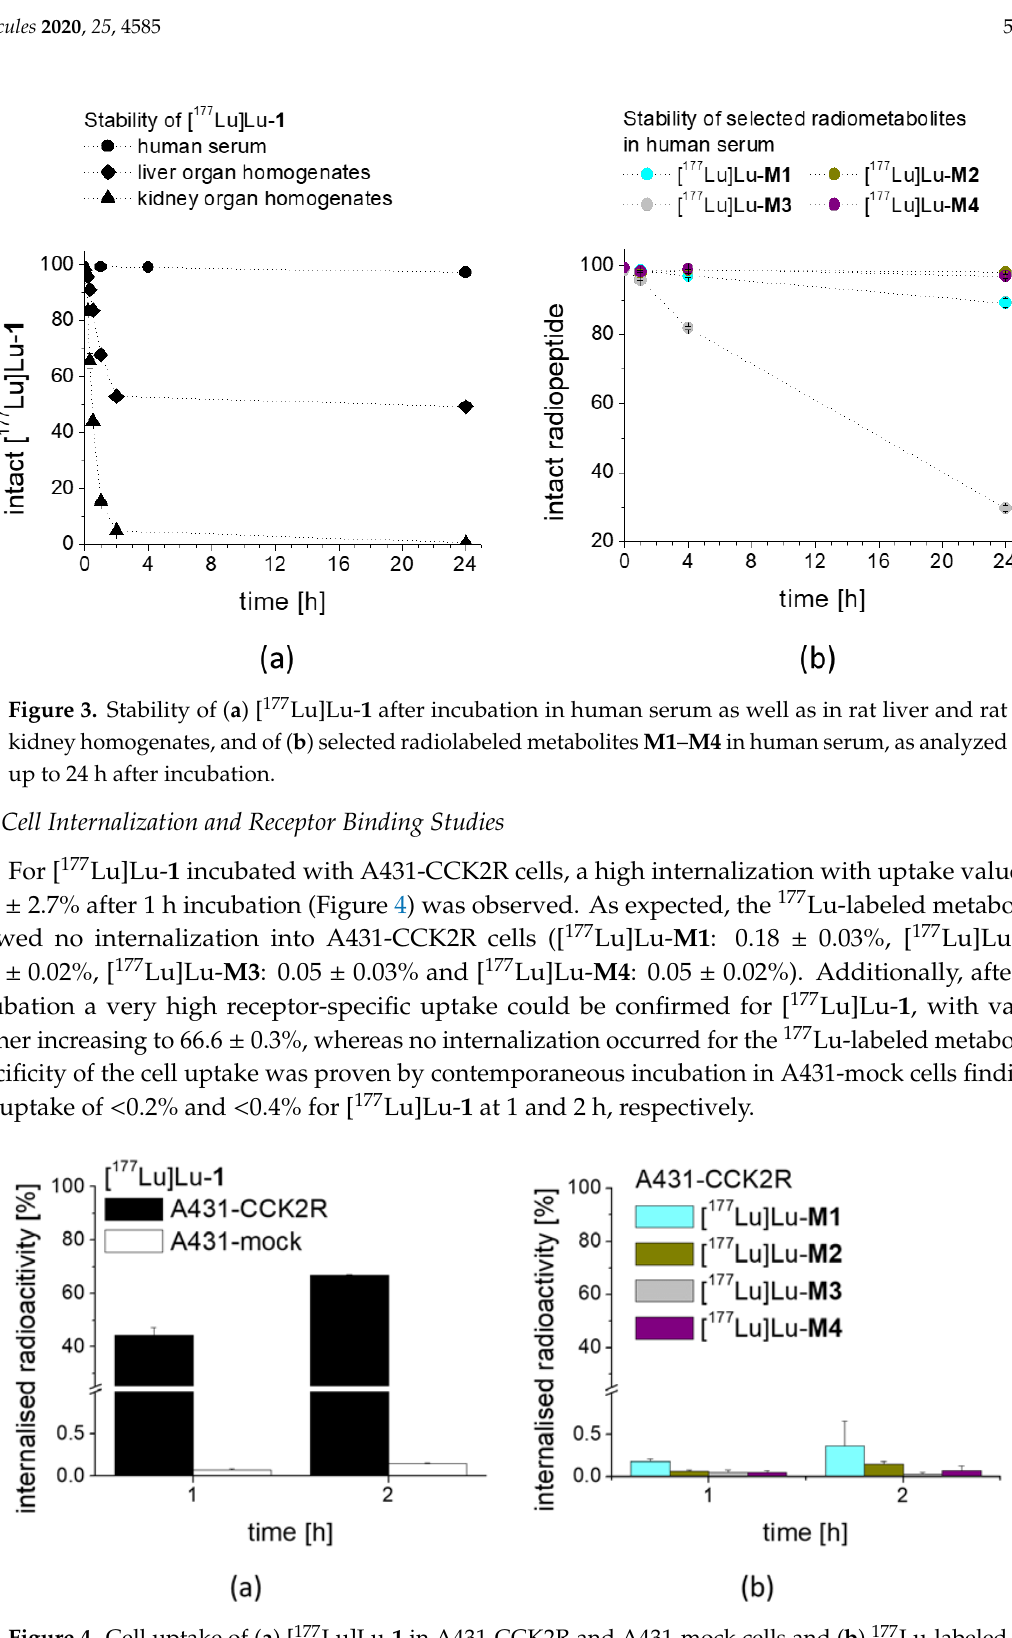
Figure 5. Competitive binding curves against [ 125 I][3-iodo-Tyr 12 ,Leu 15 ]gastrin-I for ( a ) non-labeled 1 in comparison with pentagastrin, as well as ( b ) non-labeled M1 – M4. 2.4. Stability In Vivo and Biodistribution Studies The metabolic stability in vivo , as shown in Figure 6, was monitored after intravenous injection of [ 177 Lu]Lu- 1 in BALB/c mice. A high resistance against enzymatic degradation was found at 10 min post injection (p.i.) with 80.5% intact radiopeptide present in blood. A high percentage of intact radiopeptide in blood was also observable after 30 and 60 min p.i. with values of 64.1% and 56.9%, respectively. Analysis of the urine of the mice showed that only 29.1%, 19.4% and 18.0% intact